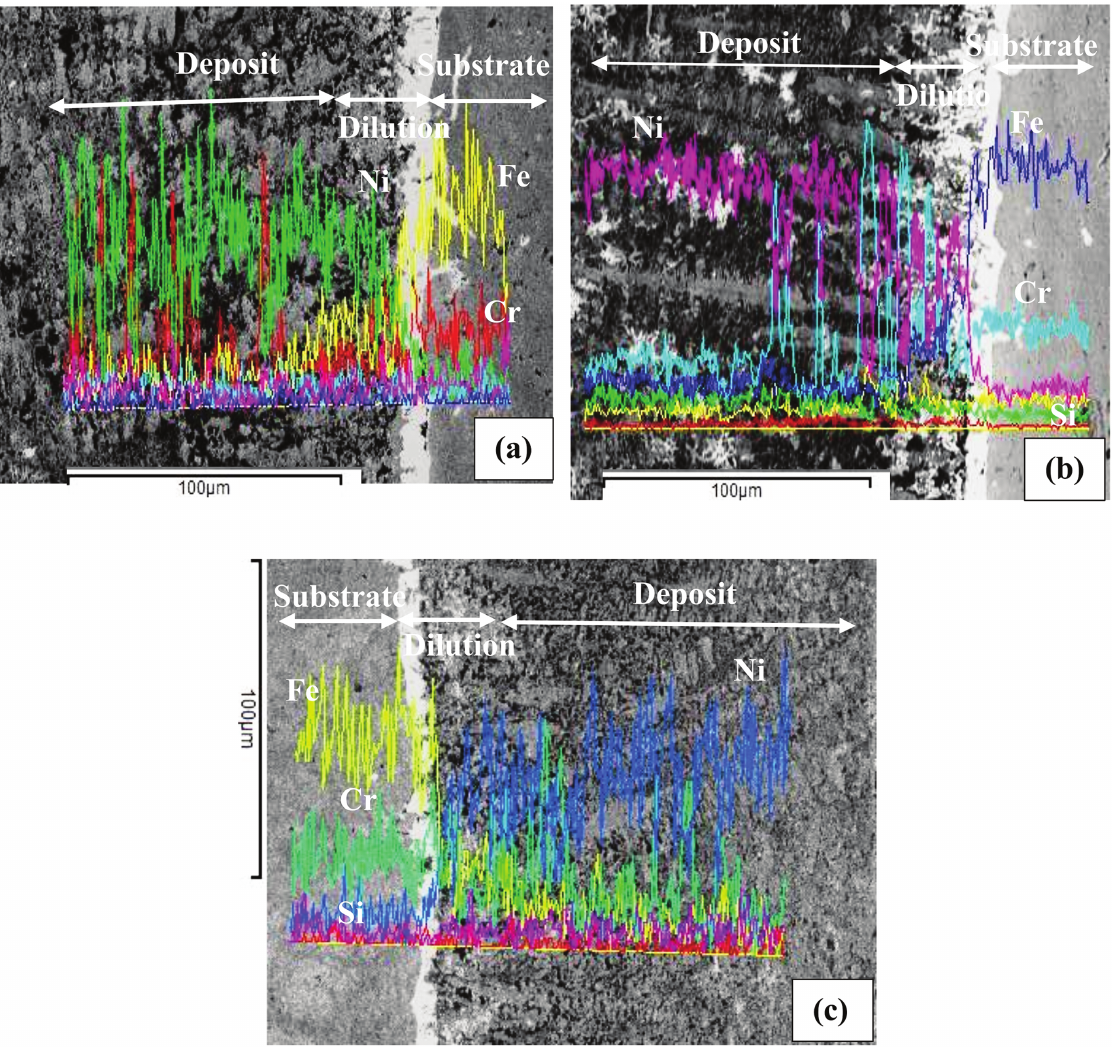
Figure 11: EDS line scan of the constituent elements across substrate/deposit interface. Hardfaced layer deposited at travel speed (a) 300mm/min, (b) 400mm/min, (c)